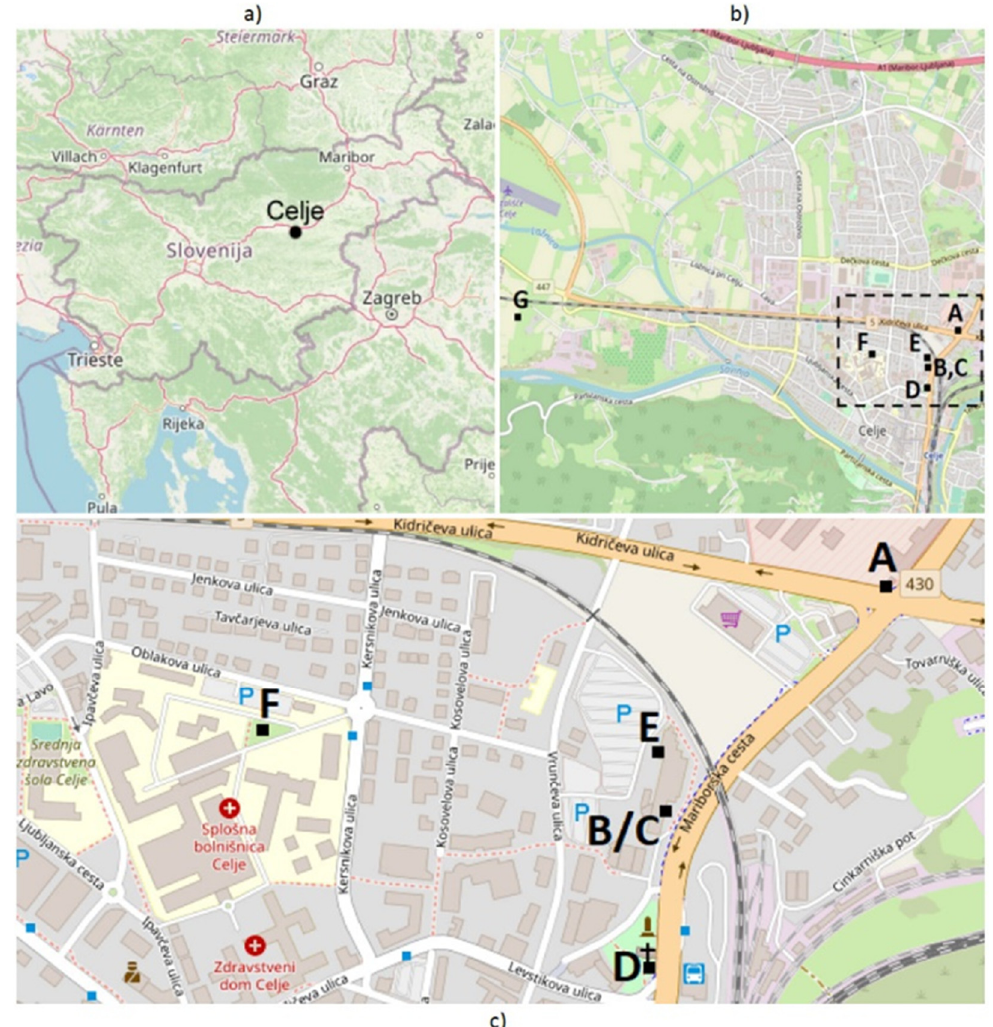
Figure 1. ( a ) Location in the region, ( b ) BC measuring points on the map of Celje with surroundings from OpenStreetMap, and ( c ) BC measuring points on the map of Celje center, from OpenStreetMap.